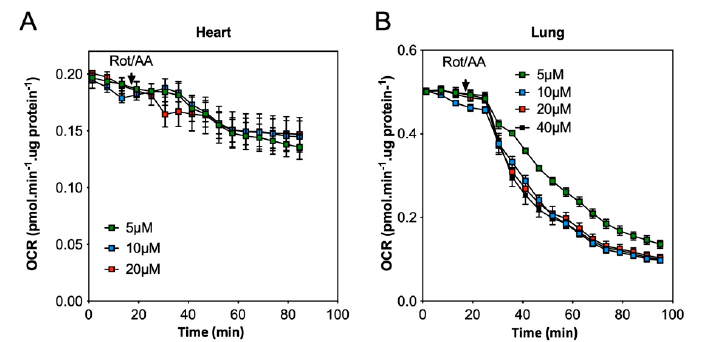
Figure A1. Quantification of OCR (pmol/min/µg protein) in heart ( A ) and lung ( B ) samples. OCR has been assessed from duplicate biopsies of three mice for each condition. Rotenone (Rot) and antimycin A (AA) were injected at the indicated concentration (see black arrow).